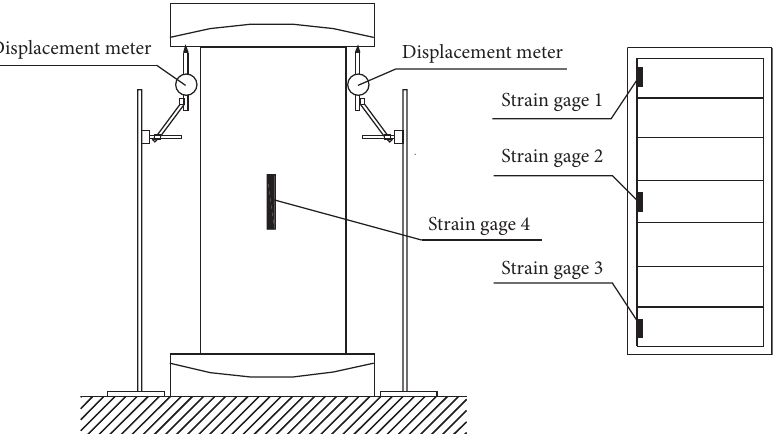
Figure 5: Layout of measuring points.